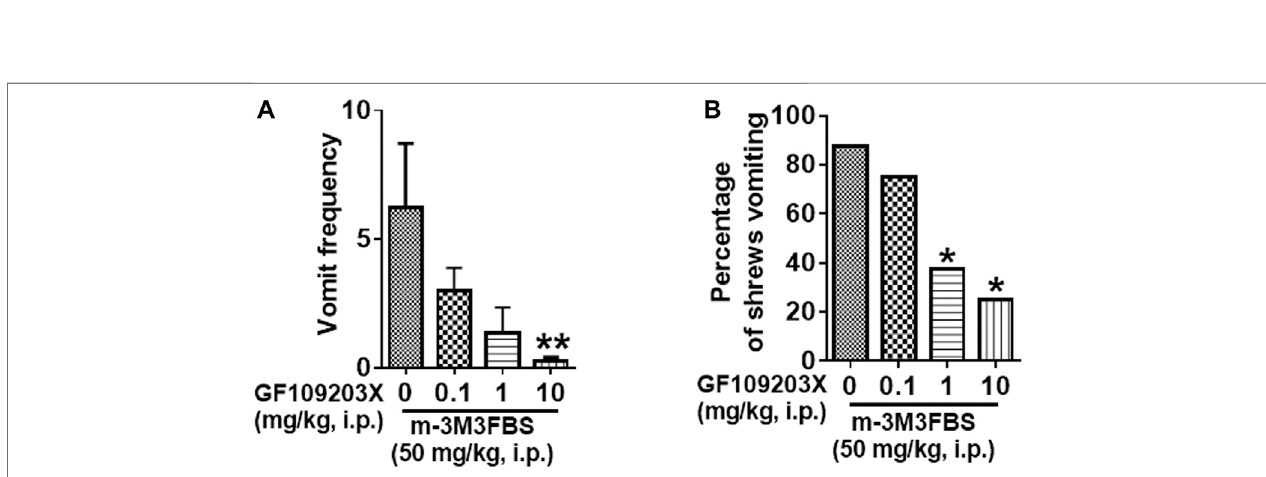
FIGURE5| TheantiemeticeffectsofthePKCinhibitorGF109203Xagainstm-3M3FBS-inducedemesis.Differentgroupsofleastshrewsweregivenaninjectionof either the corresponding vehicle, or varying doses of GF109203X (i.p.) ( n (cid:1) 8 per group) 30 min prior to m-3M3FBS injection (50 mg/kg, i. p.). Emetic parameters were recorded for the next 2 h. (A) The frequency of emesis was analyzed with Kruskal-Wallis non-parametric one-way ANOVA followed by Dunnett ’ s post hoc test and presented as mean ± SEM. (B) Percentage of shrews vomiting was analyzed with chi-square test and presented as mean. * p < 0.05, ** p < 0.01, *** p < 0.001, **** p < 0.0001 vs. 0